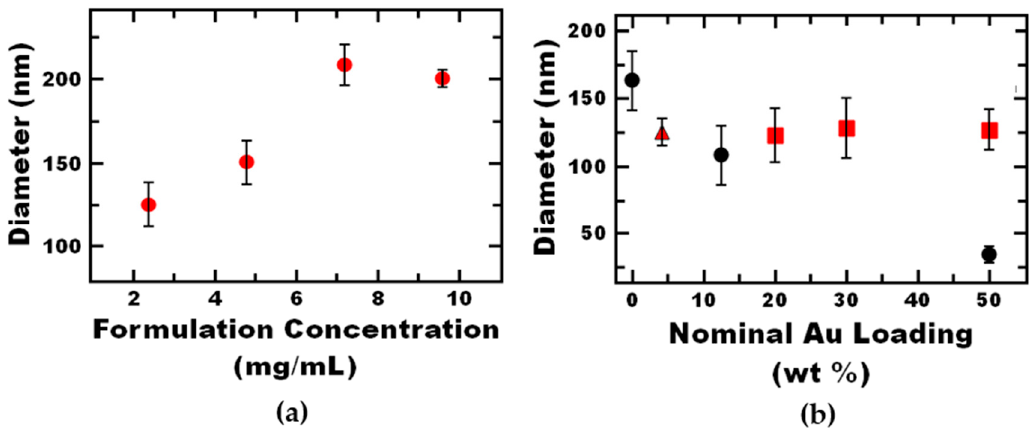
Figure 2. Hydrodynamic diameter of polystyrene nanoreactors measured by DLS with varying total nanoreactor material concentration in the formulation. ( a ) By varying the total material concentration with constant ratio of components tunable nanoreactor size between 100–200 nm. ( b ) By varying the gold to polystyrene co-precipitate ratio at a constant nanoreactor core volume (red squares), as opposed to constant mass ratio (black circles), the nominal gold loading of polystyrene nanoreactors can be tuned at constant nanoreactor size (~130 nm). The standard formulation (4 wt % nominal gold loading, 2.4 mg/mL) is shown by the red triangle.